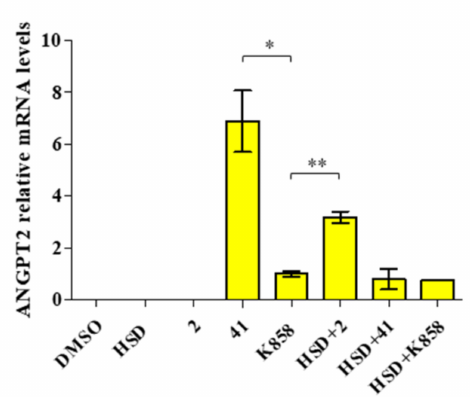
Figure 10. Relative gene expression of ANGPT2 in AGS cells treated with HSD (180 µ M), 2 (1 µ M), 41 (5 µ M), K858 (1 µ M), and a combination of HSD with each Eg5 inhibitor for 24 h. Data are expressed as relative to K858 as control (calibrator sample, defined as 1). Values represent means ± SD of three independent experiments. Y -axis, fold change. The most representative of three separate experiments is shown. ** p < 0.01; * p <